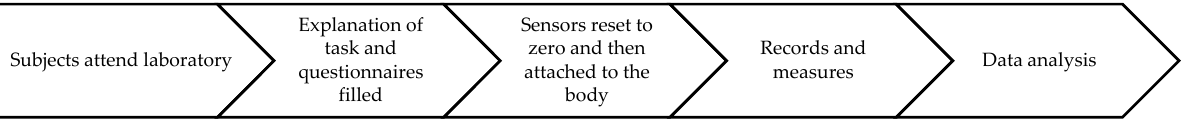
Figure 2. The procedure of the study.